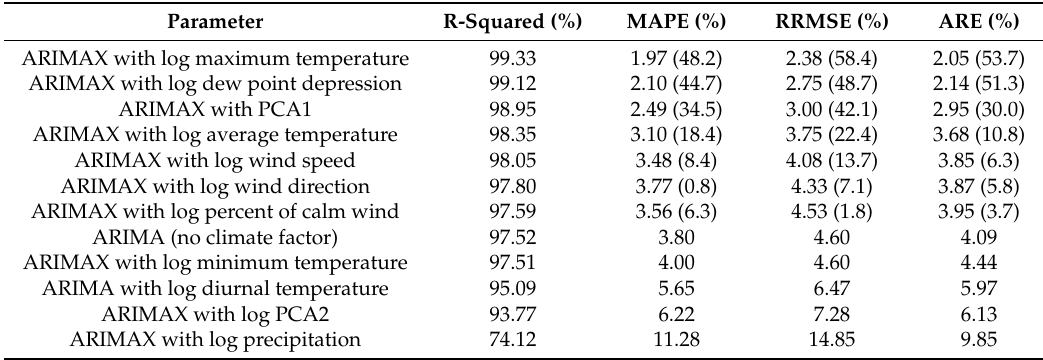
Table 4. R-Squared, Mean Absolute Percentage Error (MAPE), Relative Root Mean Square Error (RRMSE), Average Relative Error (ARE), and Percent improvement from ARIMA (in parentheses) of forecasting with meteorological parameters input series for the logarithm of water consumption (GPCD) in Las Vegas